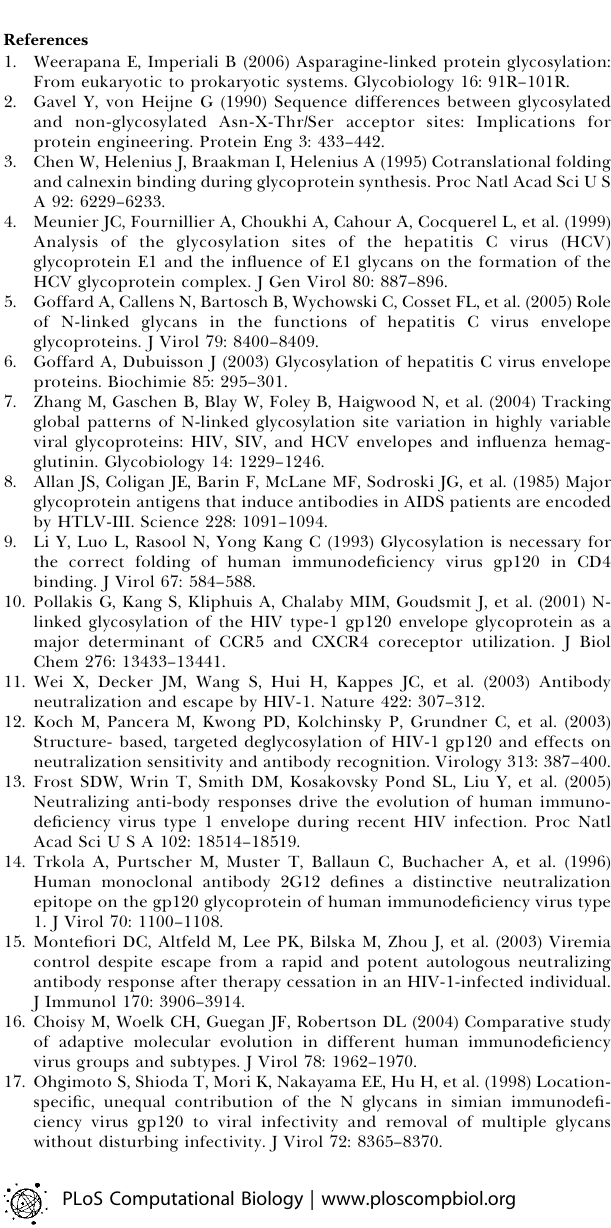
Table S1. Goodness-of-Fit and Parameter Estimates for Covarion and Nested Models Found at doi:10.1371/journal.pcbi.0030011.st001 (81 KB PDF). Table S2. Position and Frequency of Polymorphic PNGSs Applied to Bayesian Networks Found at doi:10.1371/journal.pcbi.0030011.st002 (37 KB